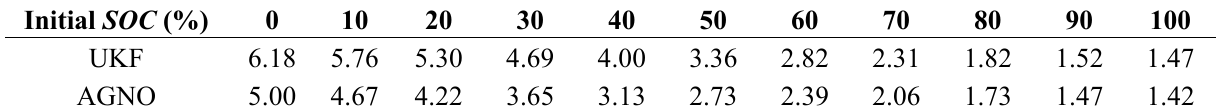
Table 3. Comparison of RMSEs (%) with different intial SOC s under FUDS test.